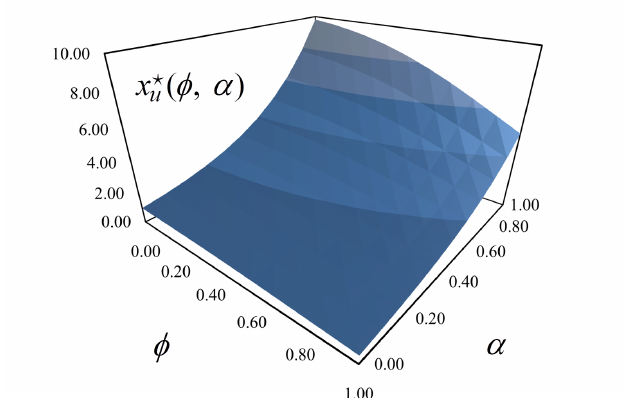
Figure 7. Nash bargaining solution ( x (cid:63) u ) with social preferences. The left-sided x -axis corresponds to the share of u ( φ ). The right-sided y -axis is the decay parameter ( α ). The z -axis denotes Nash allocations ( x (cid:63) u ( φ , α ) ).